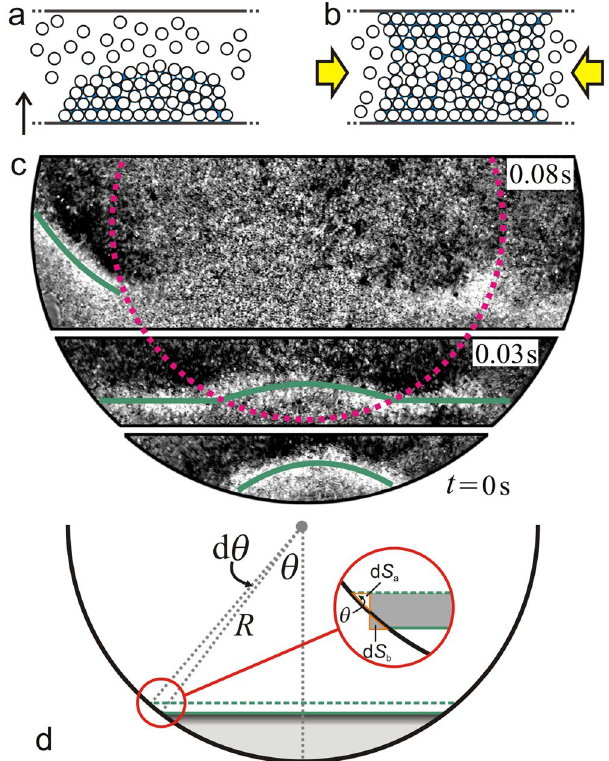
Figure 5. ( a ) A sketch illustrating the collapse of wet granular particles as they are being compressed by the upward moving container. ( b ) Further collapse of particles leads to a locally jammed region with reduced mobility, an influx of surrounding particles, and subsequently DWFs propagating outwards in the horizontal direction. ( c ) Top-view snapshots showing the initialization process of a DWF from the rim of the container driven at f = 90 Hz and Γ = 55.7. The dashed curve corresponds to a concentric arch of radius R 2 . The green curves, which highlight the fronts, are guides to the eyes. ( d ) A schematic showing a front (dark gray region) propagating one step further (from solid to dashed lines) with various definitions. d S a and d S b denote the gained and lost area of the propagating front in comparison to a rectangle of the same